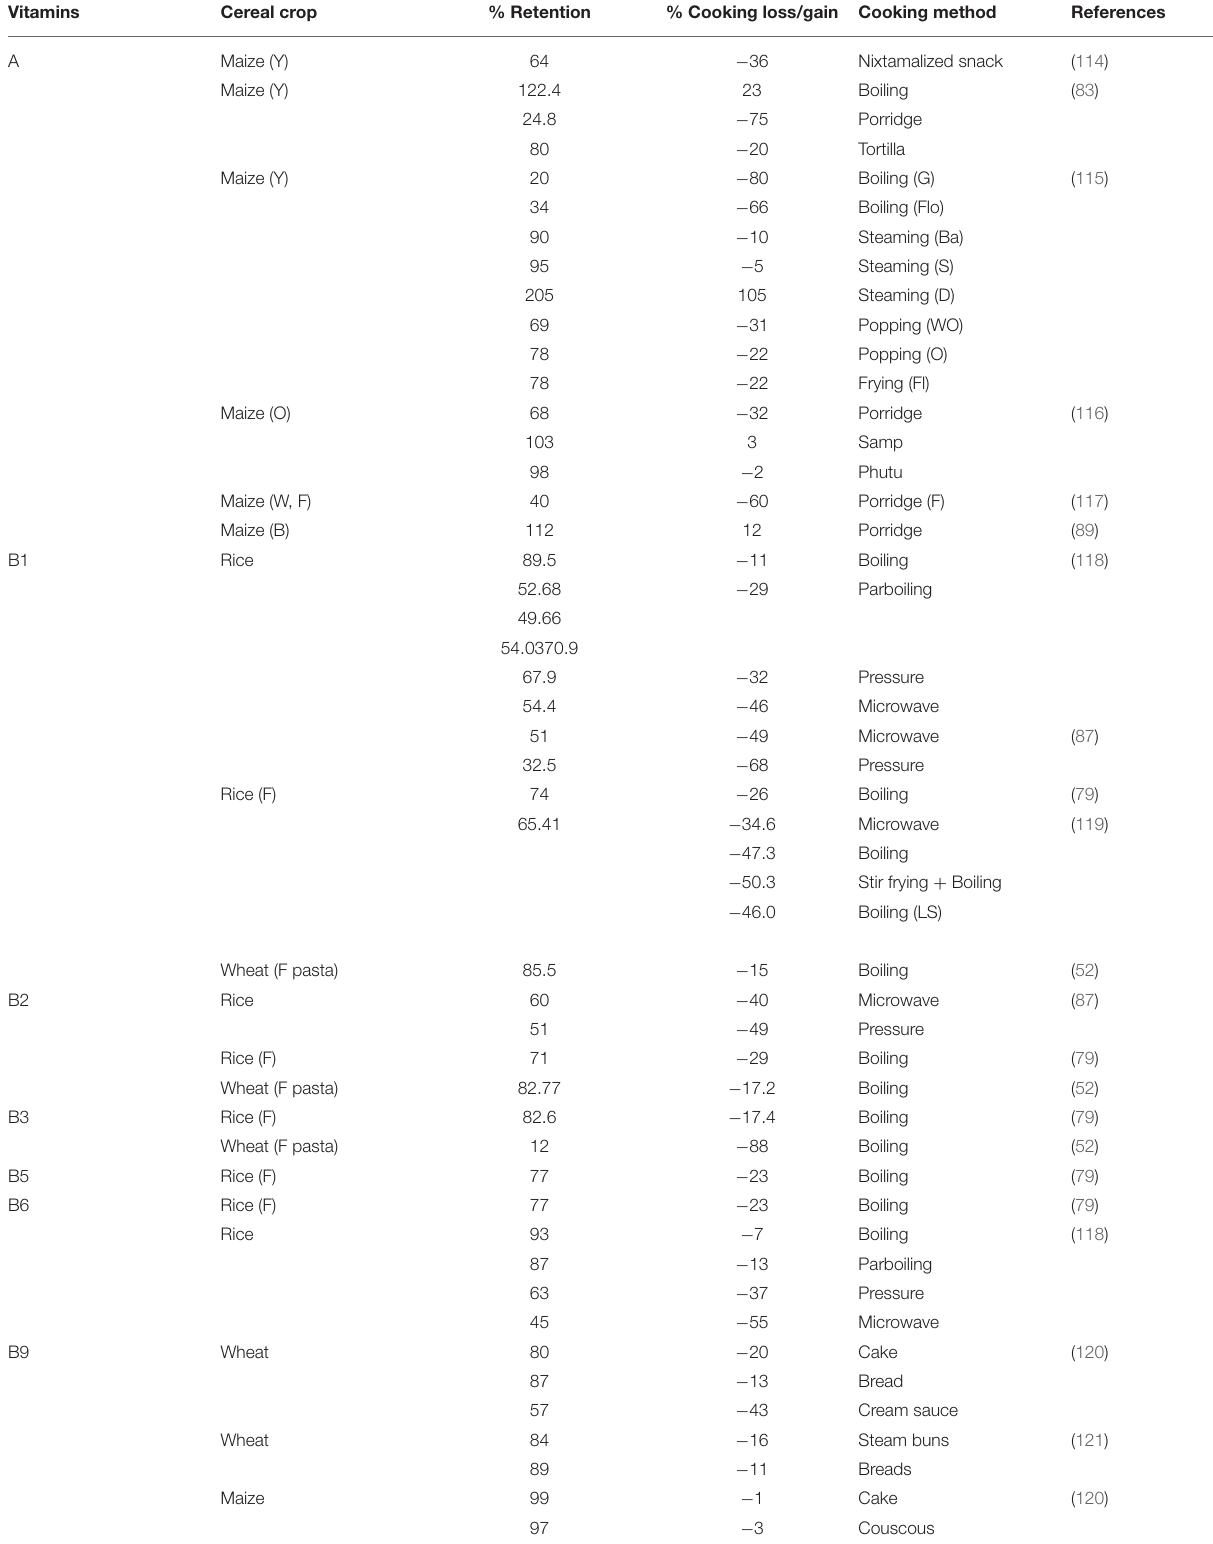
TABLE 6 | Effect of different cooking methods on vitamins content in cereals.